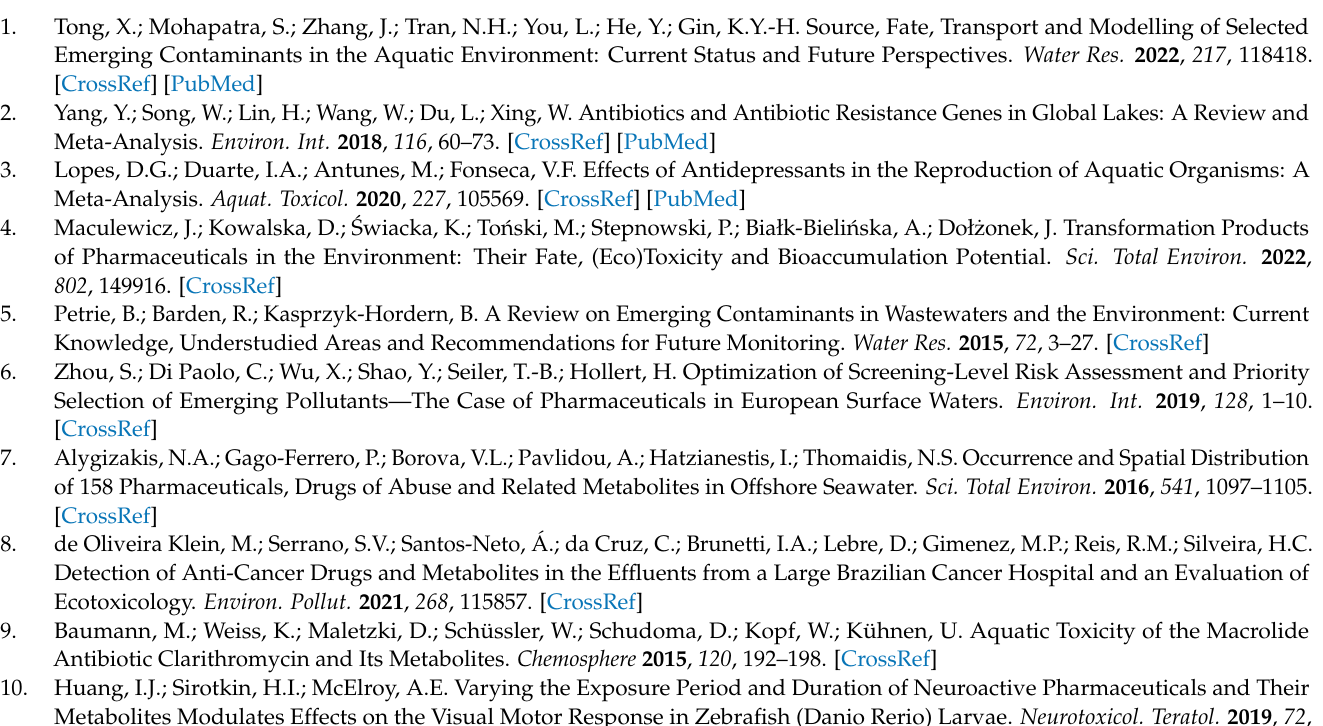
Table S1: The gradient program of mobile phase in different modes; Table S2: Experimental conditions used for LC-MS/MS; Table S3: Recoveries of target pharmaceuticals and matrix effect in water, sediment and fish; Table S4: Aquatic toxicity data and the calculated PNEC values (ng/L) for algae, in-vertebrate and fish for target pharmaceuticals; Figure S1: The risks of pharmaceutical metabolites and their parents to algae (A), in-vertebrates (B), and fish (C) in different sampling sites. References [42–56] are cited in Supplementary